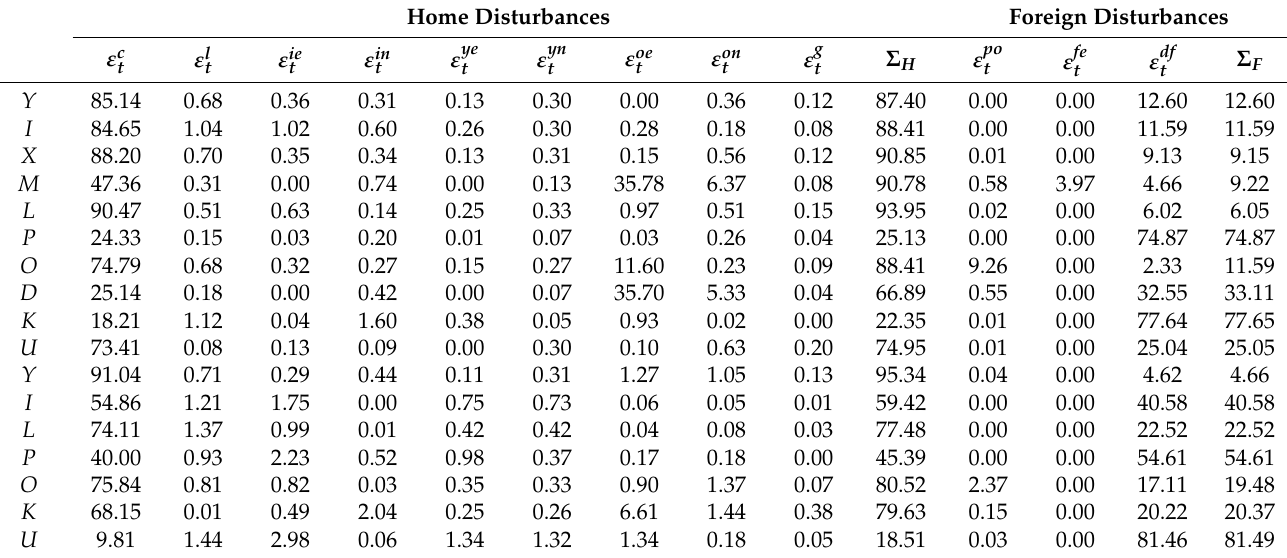
Figure A1. Additional VAR impulse response functions. Note : blue solid lines: estimated impulse response function; red dashed lines: 95% confidence intervals. Table A4. Variance decomposition for sectoral